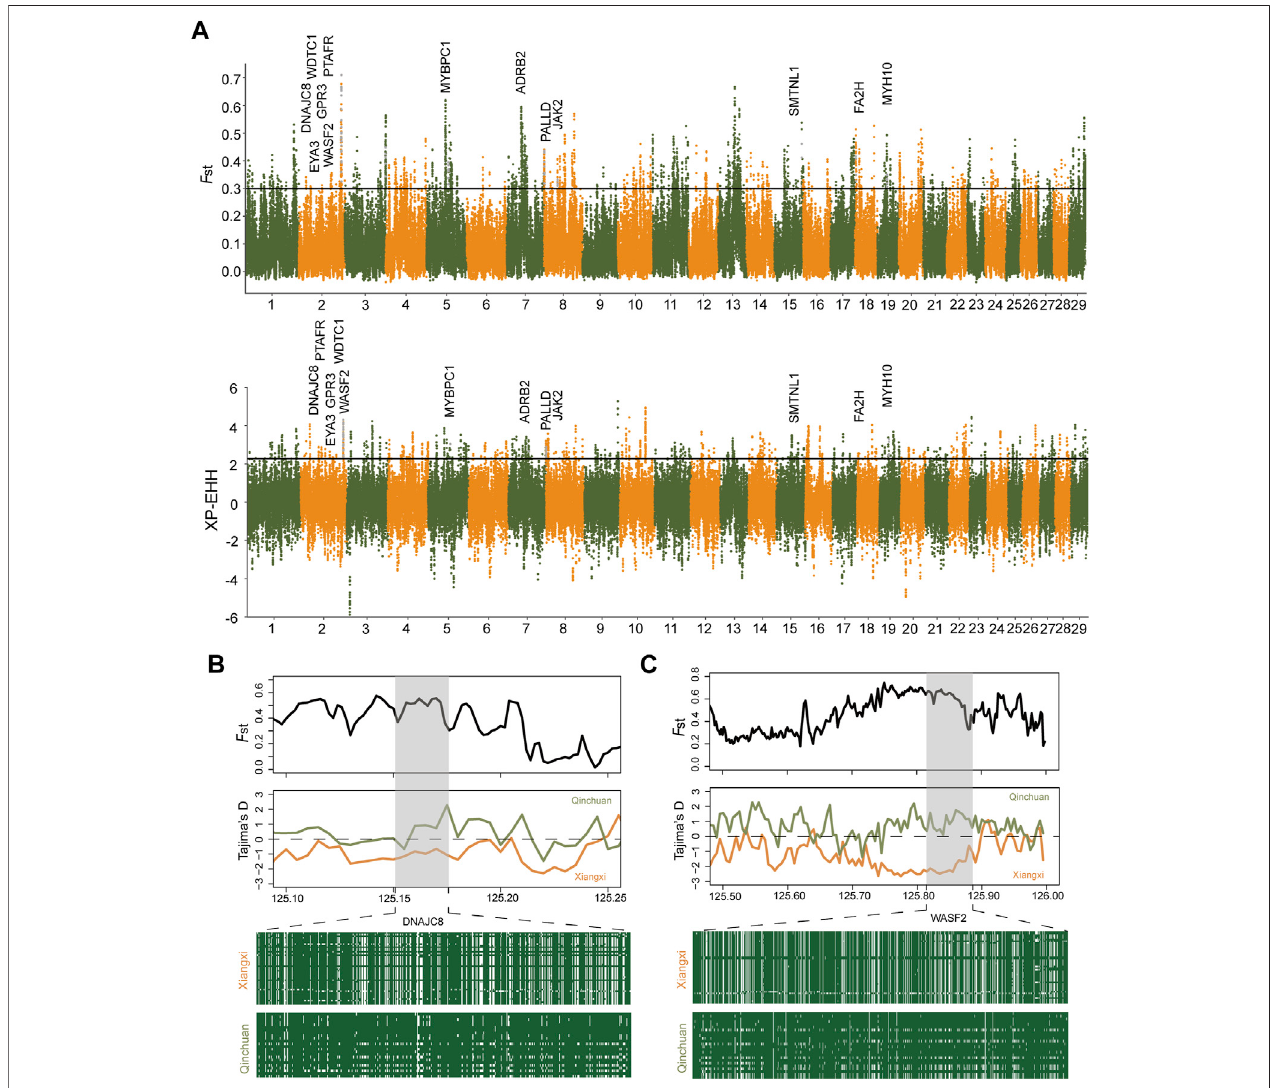
FIGURE4| SelectivesignalsbetweenXiangxicattleandQinchuancattle. (A) Manhattanplotofselectivesweepsby F ST andXP-EHHmethods. F ST andTajima ’ sD plots of DNAJC8 gene (B) and WASF2 gene (C) . Haplotype diversity at the example genes (B,C) .